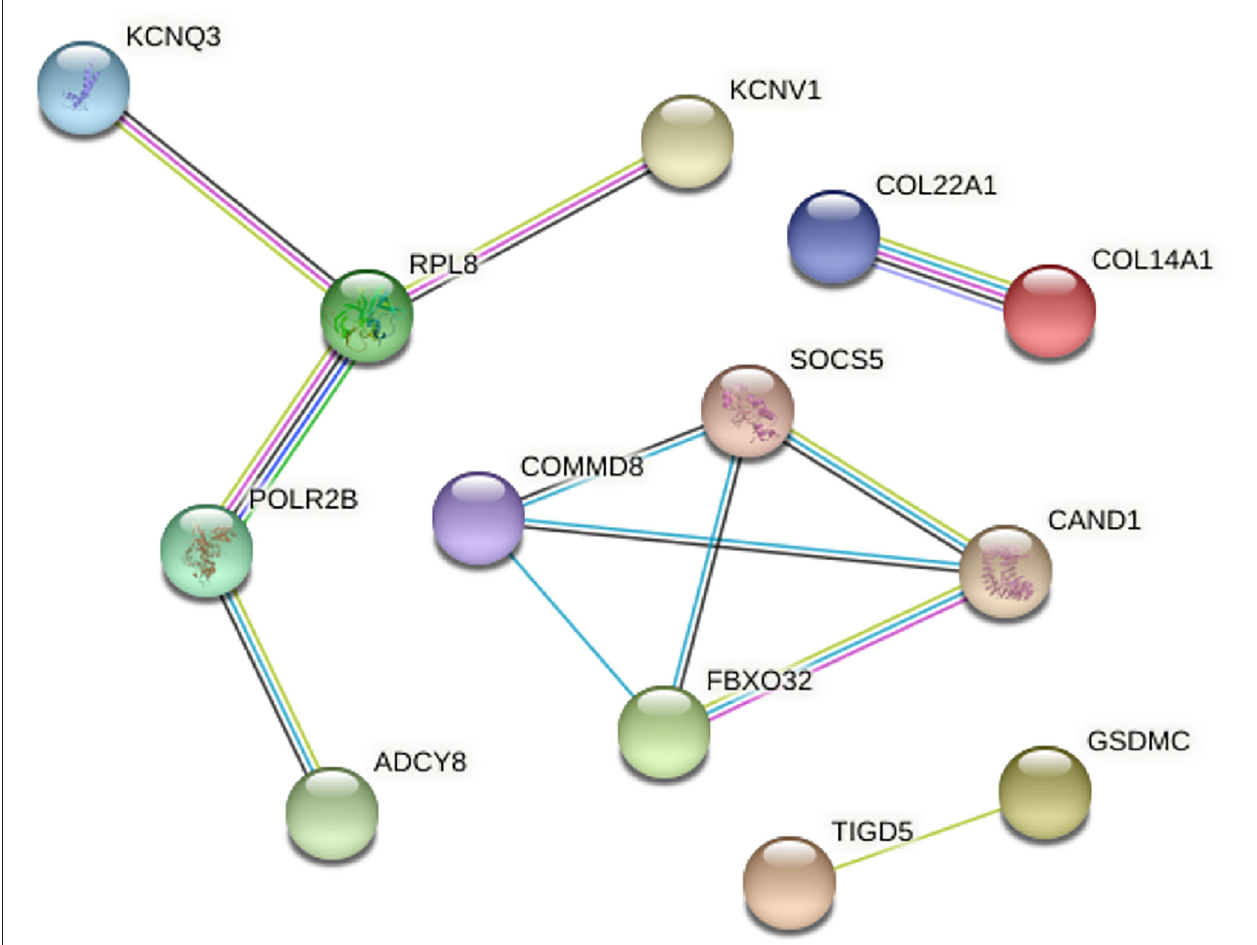
FIGURE 4 | Protein-to-protein interaction analysis with the commonly mutated genes between canine and human melanoma. The disconnected nodes were excluded and four different networks were identified. Figure generated using the online tool STRING